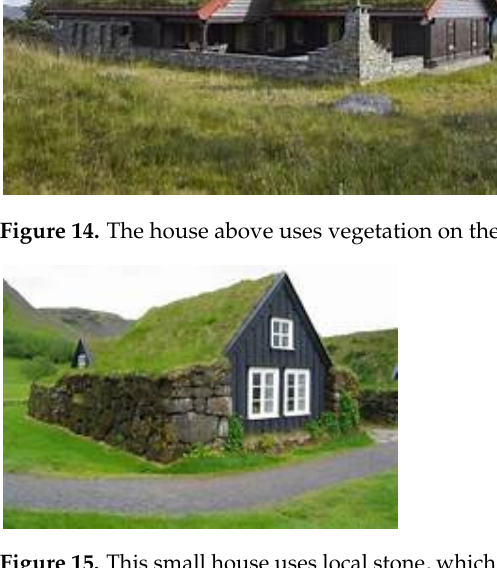
Figure 15. This small house uses local stone, which is abundant in Central Appalachia, and also has a grass roof covering to provide insulation and reduce energy usage.